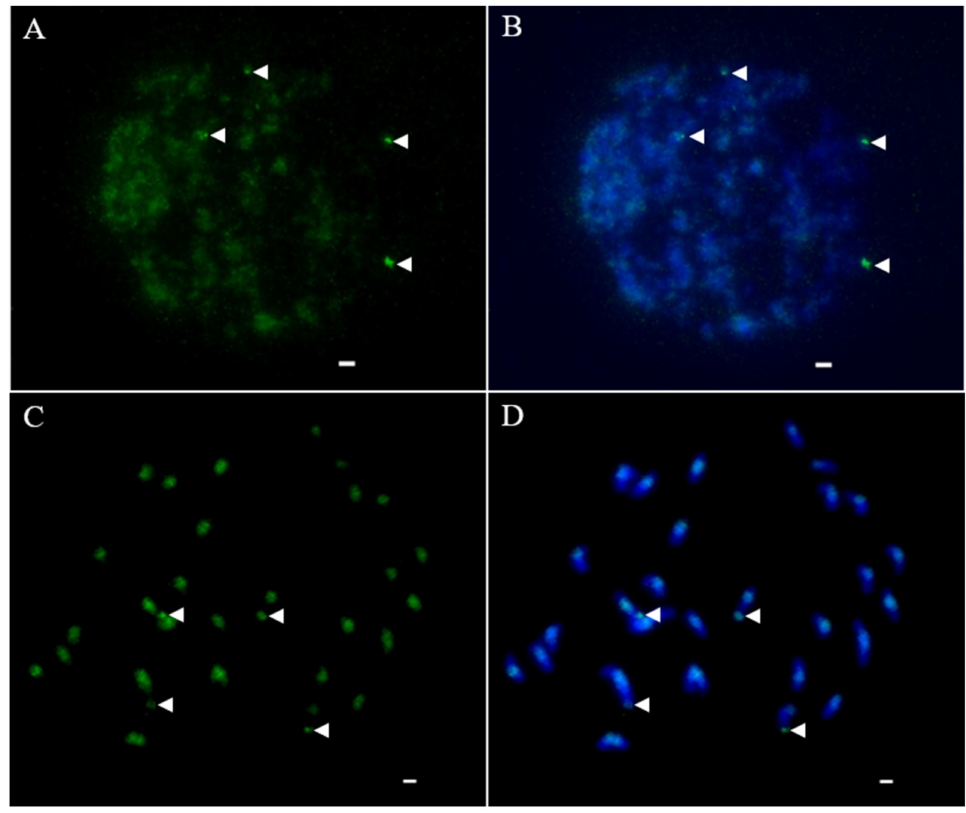
Figure 4. FISH results of Ty1- copia RT sequences on different stage chromosomes of P. purpureum (2 n = 4 x = 28). Nucleus and prometaphase chromosomes stained with DAPI ( B , D ). Total Ty1- copia RT probes on the interphase nucleus ( A ) and metaphase chromosomes ( C ). White arrows indicated obvious concentrated signals in telomeres. Scale bars = 5 µ